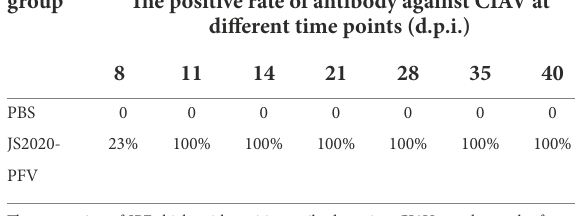
TABLE 2 Detection of antibodies against